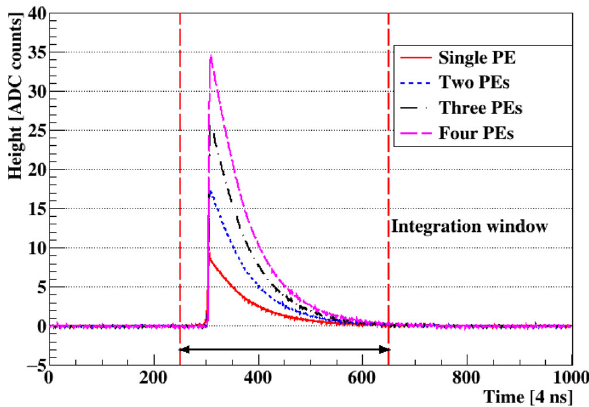
Fig. 5 Average waveforms of different PEs from the top SiPM. The ones from the bottom SiPM are very similar